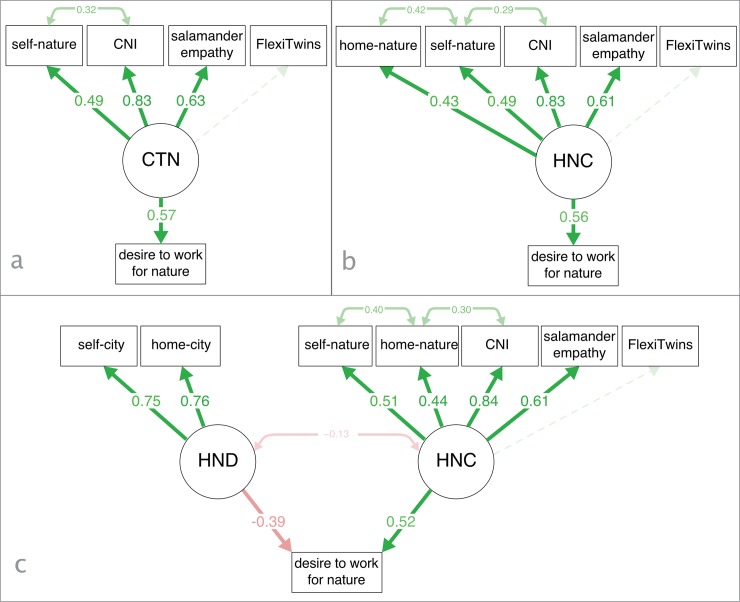
Three structural equation models to predict children’s desire to work for nature.a) CTN model; b) HNC model; c) HND-HNC model. Latent variables are in circles, measured variables in rectangles, and the lines show standardized parameter estimates.